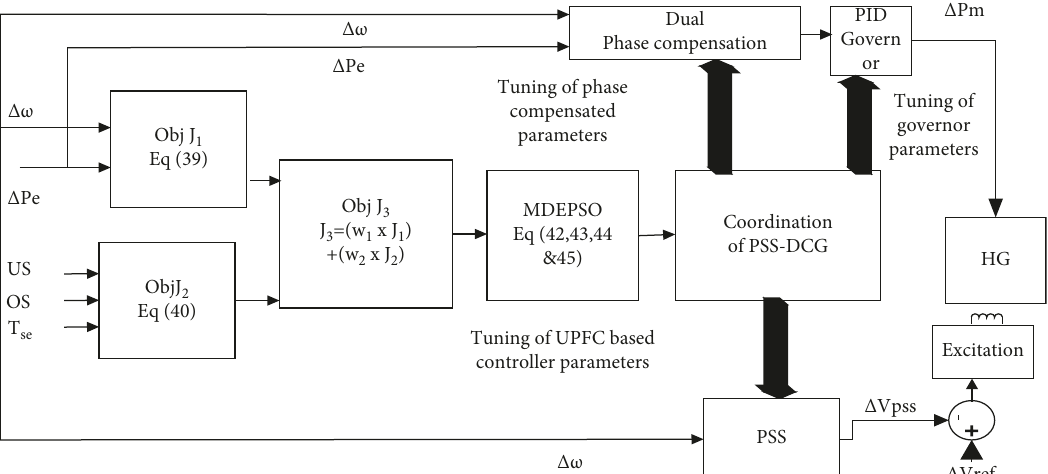
Figure 6: Strategy of proposed control action.